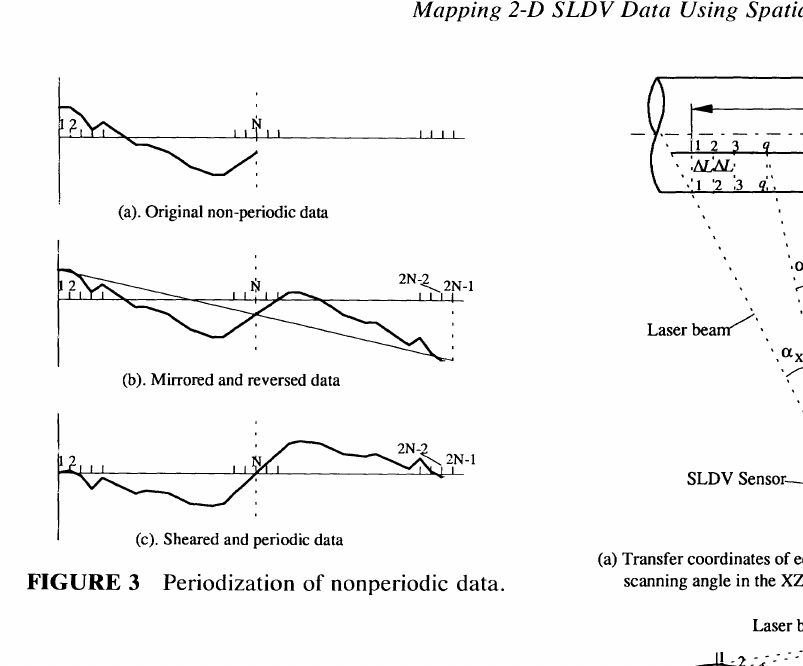
FIGURE 3 Periodization of nonperiodic data.